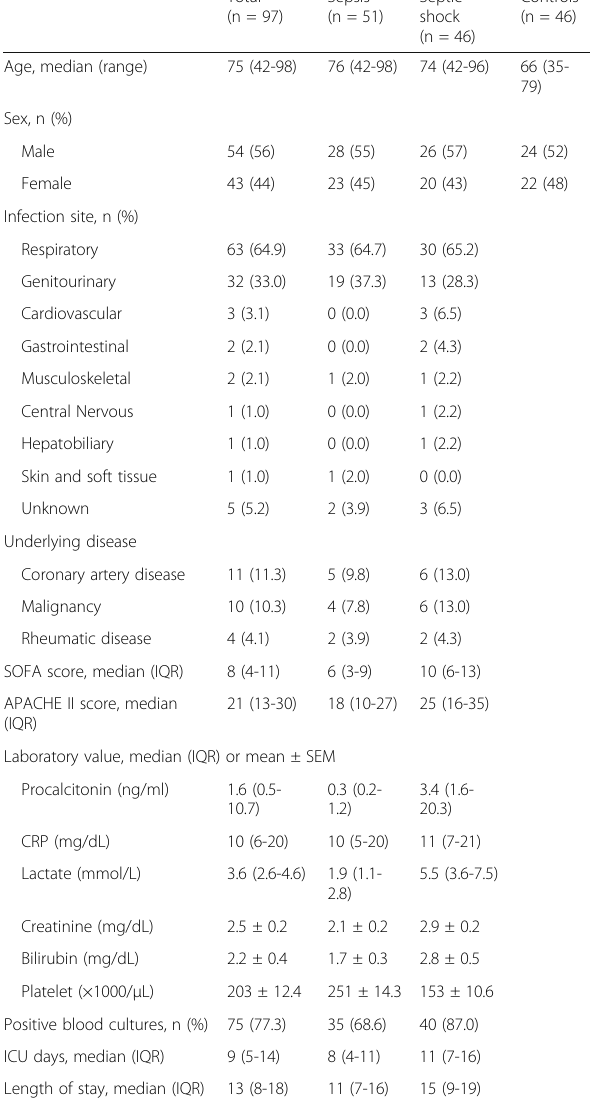
Table 1 (abstract P14). Baseline Characteristics of Study